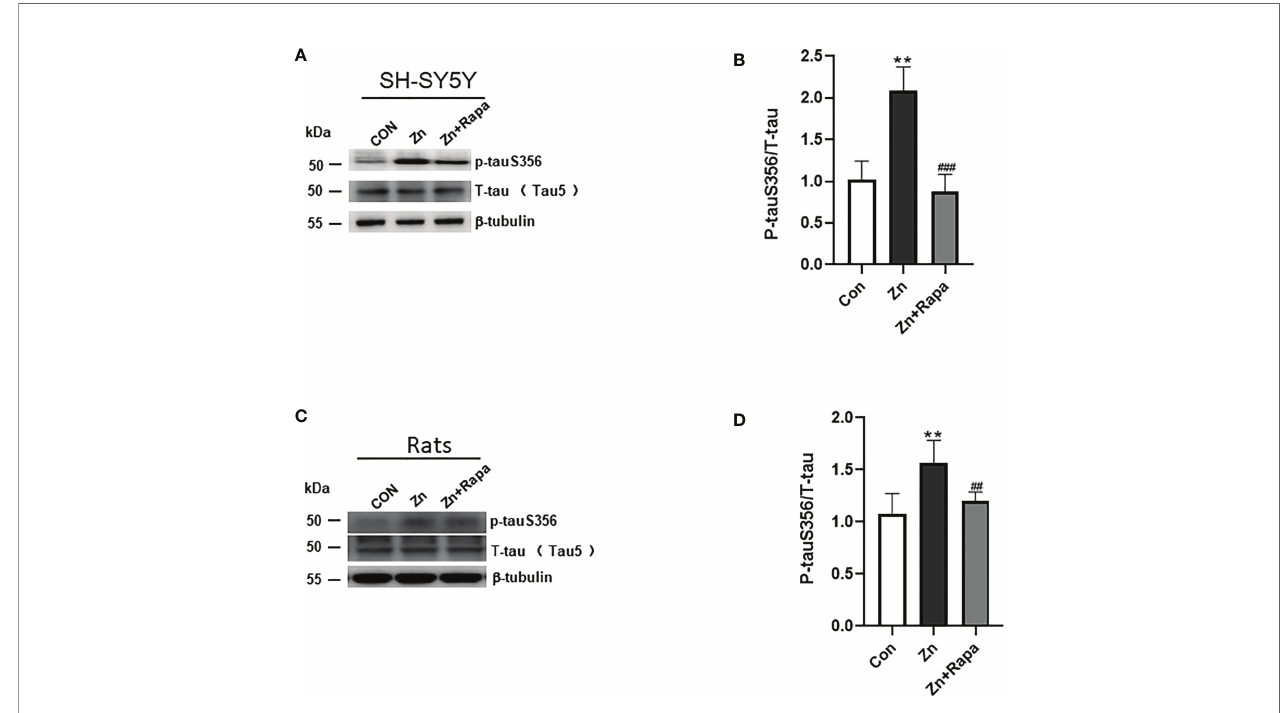
FIGURE 2 | Rapamycin decreases the expression ratio of p-tau S356/T-tau in SH-SY5Y cells. (A, B) Representative blots and quanti fi cation of the expression ratio of p-Tau S356/T-tau (tau5) proteins in SH-SY5Y cells of the control, zinc, and zinc+rapamycin groups. n = 3 experiments per group. (C, D) Representative blots and quanti fi cation of the protein expression ratio of p-Tau S356/T-tau (tau5) in rats in the control, zinc, and zinc+rapamycin groups. n = 4 rats per group in the same membrane. **p < 0.01 vs. control group; ###p < 0.001 vs. rapamycin